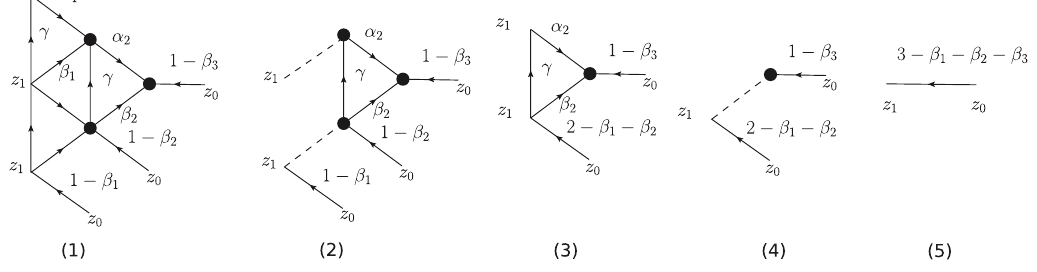
Figure 9 . Reduction of the eigenfunction (cid:9)( x 1 ; x 2 ; x 3 power [ z 0 z 1 ] (cid:12) 1 + (cid:12) 2 + (cid:12) 3 (cid:0) 3 . Dashed lines stand for (cid:14) (2) ( z ), see also (A.5). We reduce z 3 ; z 2 (cid:0) (1). By applying triangle-star relations to the (cid:12)rst row of triangles (1) we obtain (cid:14) function kernels. We integrate out (cid:14) functions (2) and we open the triangle in (3) to a a star and put together the points z 1 obtaining (4). The (cid:14) function is integrated (4), leading to the full reduction of the eigenfunction to a simple line